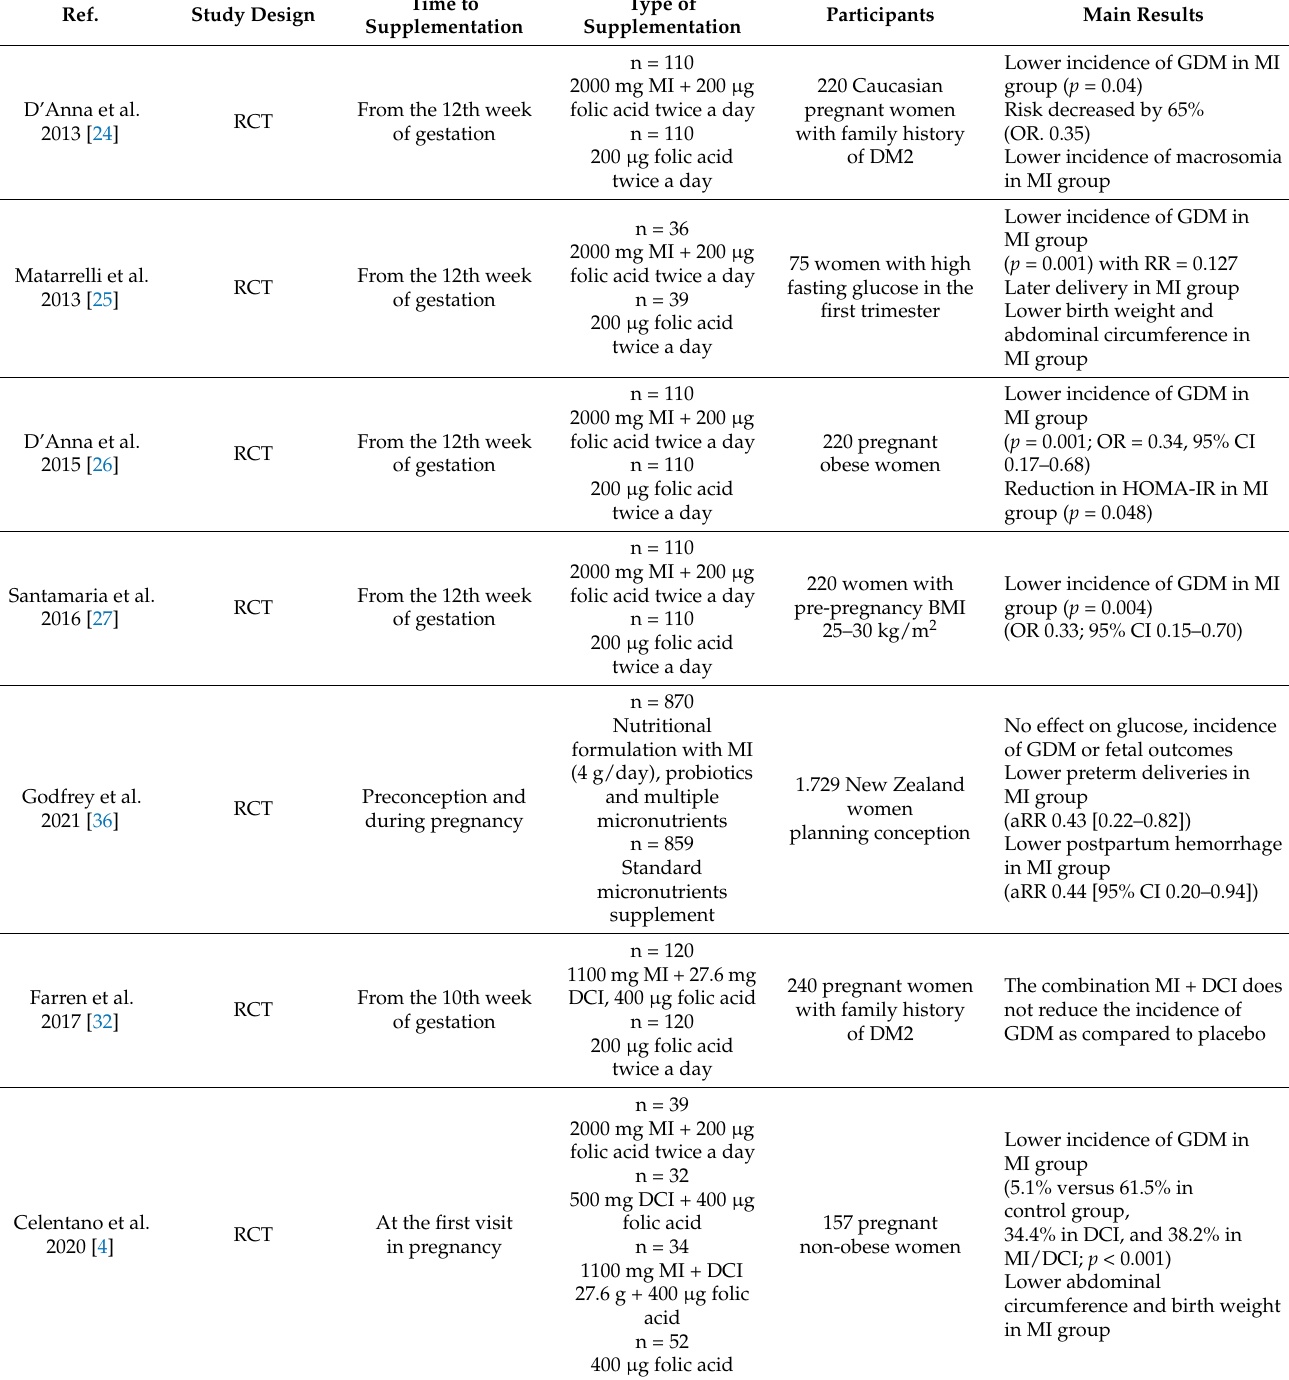
Table 1. Studies on the effect of inositol supplementation to prevent